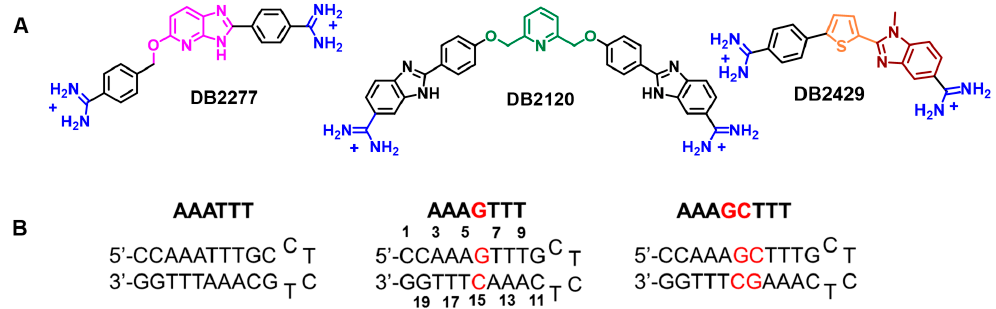
Figure 2. ( A ) Structures of three very different designed mixed-sequence DNA minor groove binders; ( B ) DNA hairpin oligomer duplexes used in their study. DNA sequences with 5 ′ -biotin labels were used for SPR studies.